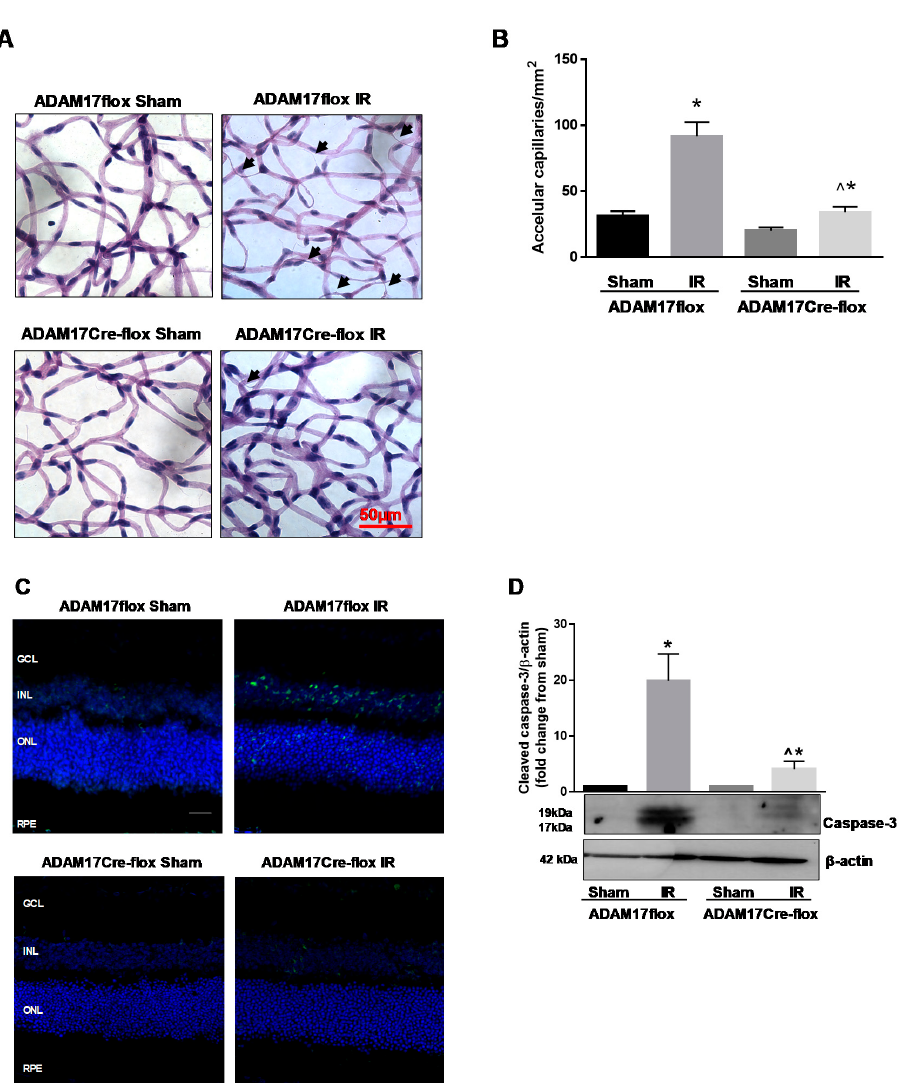
Figure 5. IR-induced vascular degeneration is reduced in mice with genetic ablation of endothelial ADAM17. ( A ) Representative images of retinal vascular digest and ( B ) quantification of degenerate capillaries in control ADAM17flox and ADAM17Cre-flox mice subjected to retinal IR. Arrows point at degenerate capillaries. Values are mean ± SE. * p < 0.05 vs. corresponding sham; ^ p < 0.001 vs. ADAM17flox IR; n = 5 for each group. Scale bar, 50 µm. ( C ) TUNEL (terminal deoxynucleotidyl transferase dUTP nick end labeling) staining (green) to assess apoptosis in retinal cryosections 48 h after reperfusion. Nuclei were stained with DAPI (blue). Scale bar, 20 µm. ( D ) Representative Western blots and densitometric analysis of cleaved caspase-3 evaluated 48 h after reperfusion. Actin was used as an internal control. Values are mean ± SE. Results are presented as fold change from sham. * p < 0.05 vs. corresponding sham; ^ p < 0.05 vs. ADAM17flox IR; n = 5 in each group.